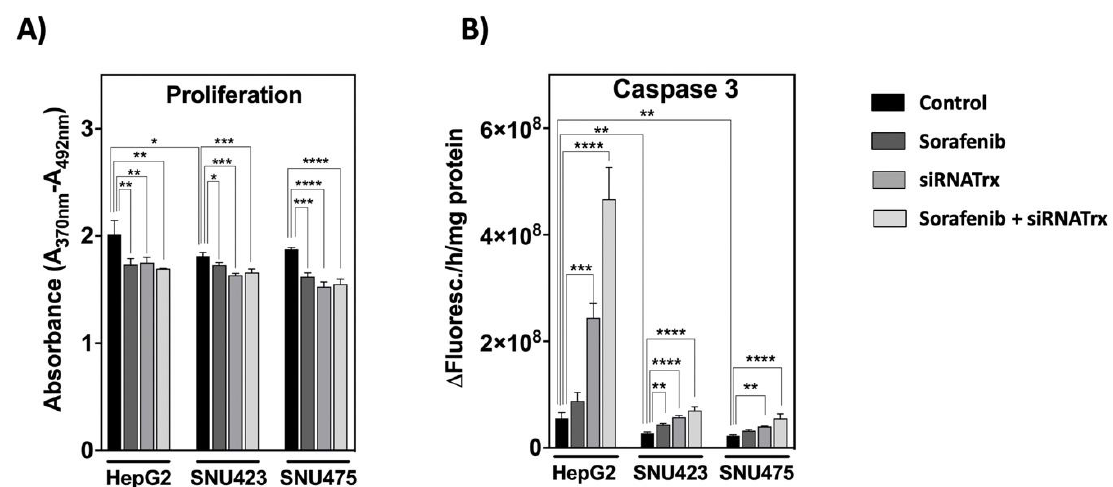
Figure 8. Proliferation and apoptosis of HCC cell lines subjected to Sorafenib and / or siRNATrx1 treatments. ( A ) Proliferation as determined by BrdU incorporation into DNA and ( B ) caspase-3 activity determined by fluorescence using a specific peptide substrate. Three different experiments ( N = 3) for each cell line. p values 0.0332 (*), 0.0021 (**), 0.0002(***), <0.0001 (****), see Materials & Methods for statistical details .